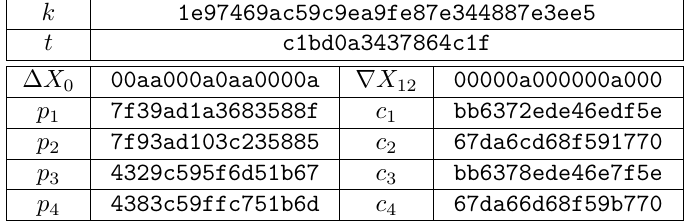
Table 16: The input/output differences, plus a right quartet for 12-round boomerang distinguisher